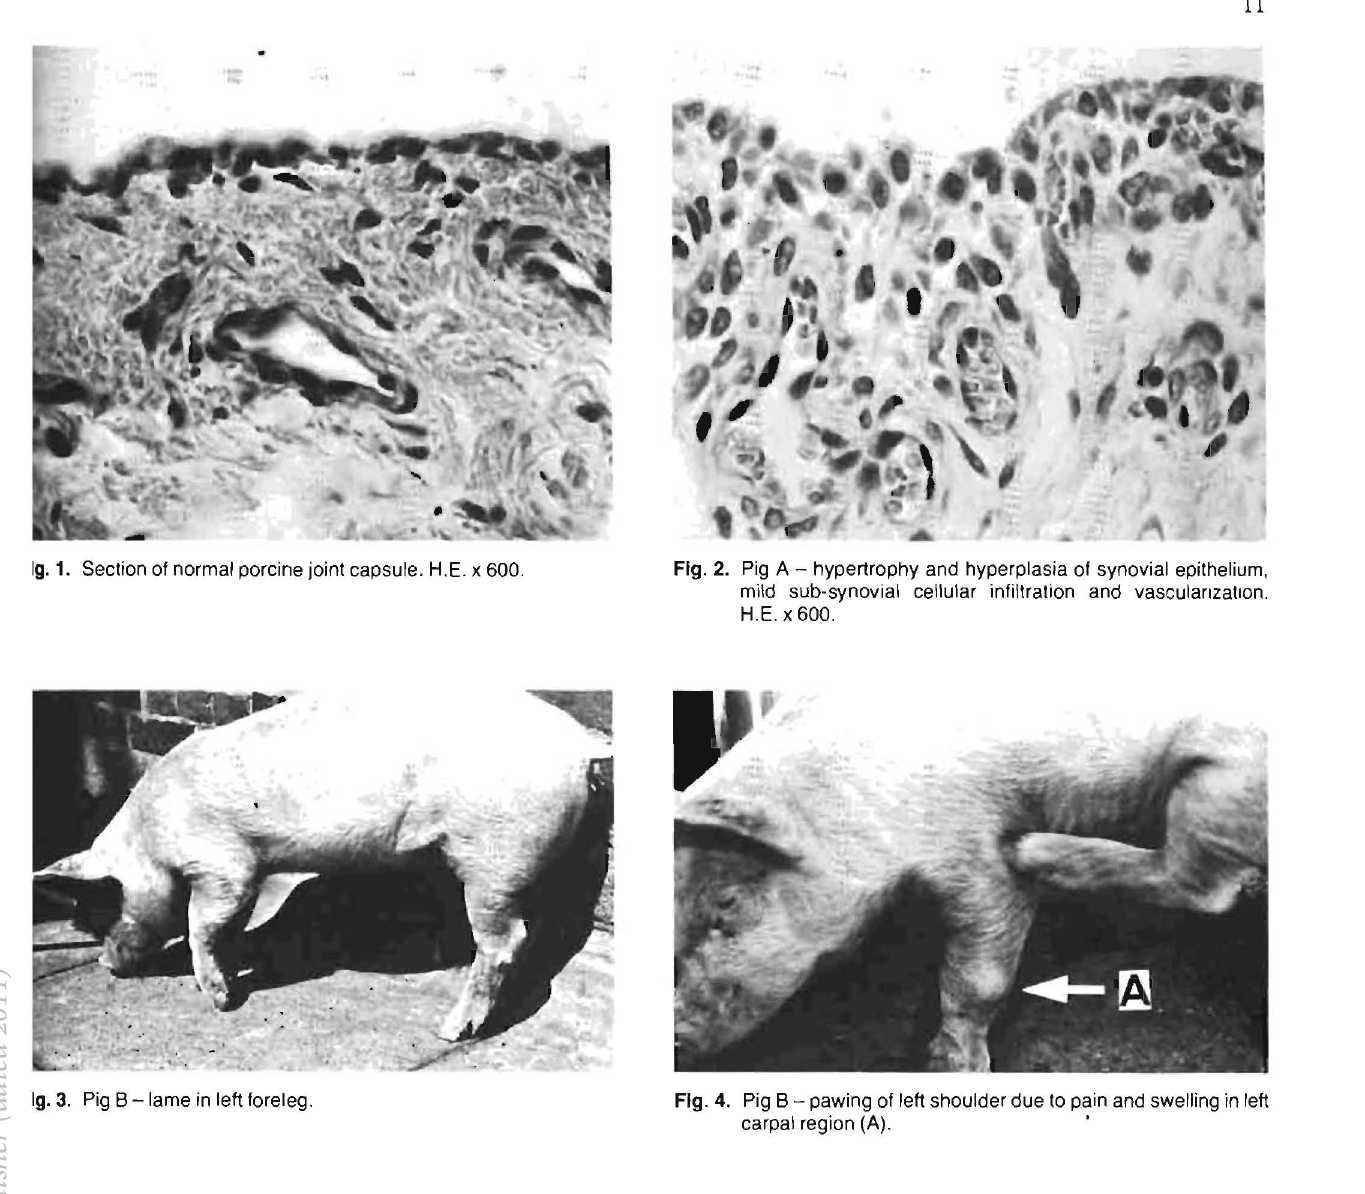
Fig. 4. Pig B - pawing of left shoulder due to pain and swelling in left carpal region (A).